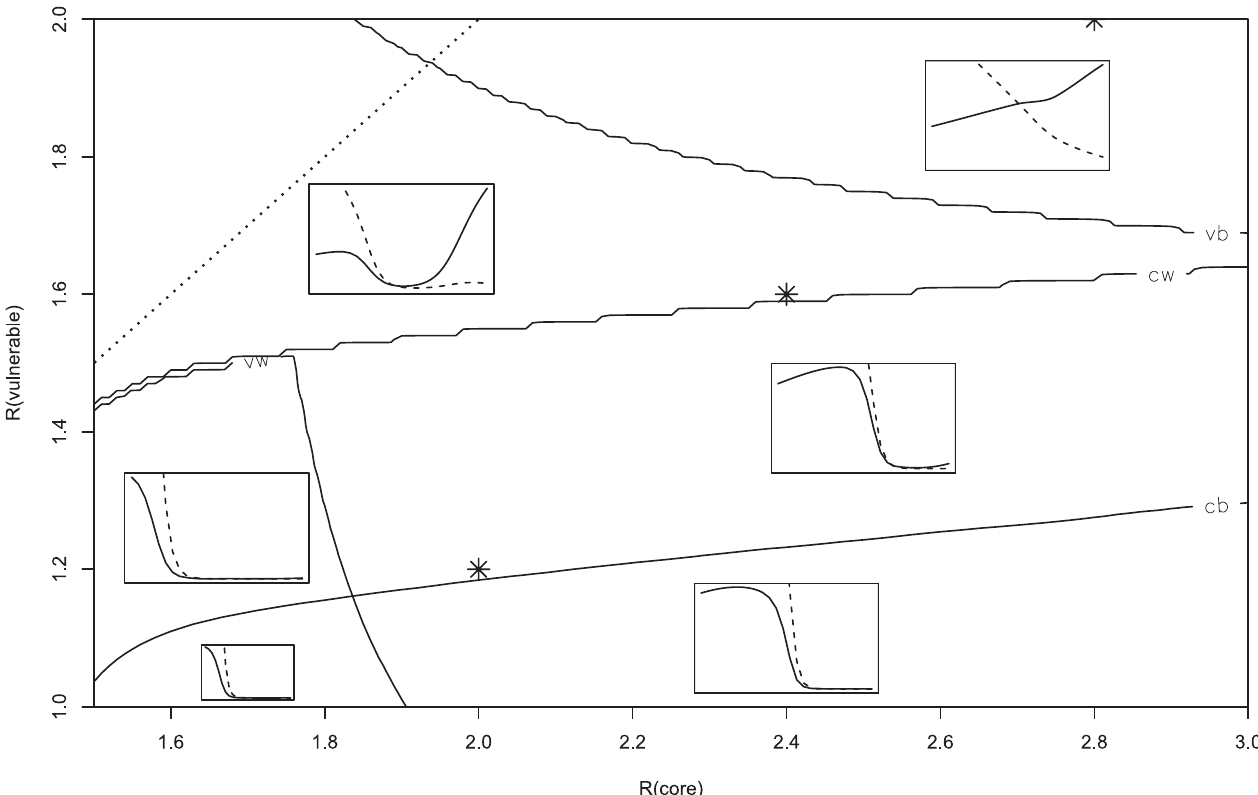
Figure 3. Parameter Regions with Different Qualitative Responses to Changes in Vaccine Allocation Insets show vaccine allocation tradeoffs at different points in parameter space, in the style of Figures 1 and 2. Contour lines (solid) separate regions in which the strategy that vaccinates only vulnerable individuals (v) or the one that vaccinates only core individuals (c) is or is not the best (b) or worst (w) on the curve describing changes in incidence in the vulnerable population. Two strategies on a given curve are deemed equivalent if they differ by less than 0.1% of the curve’s maximum value. The large region in the middle right shows the case in which neither extreme strategy is best or worst; the extreme properties of any other region are described by the names of the line or lines separating the region from the middle right region. Asterisks correspond to the parameters shown in Figure 1. The dotted line shows values for which R is the same for both groups: our assumption that the core group transmits the disease more effectively than the vulnerable group does not hold in the region above this line.